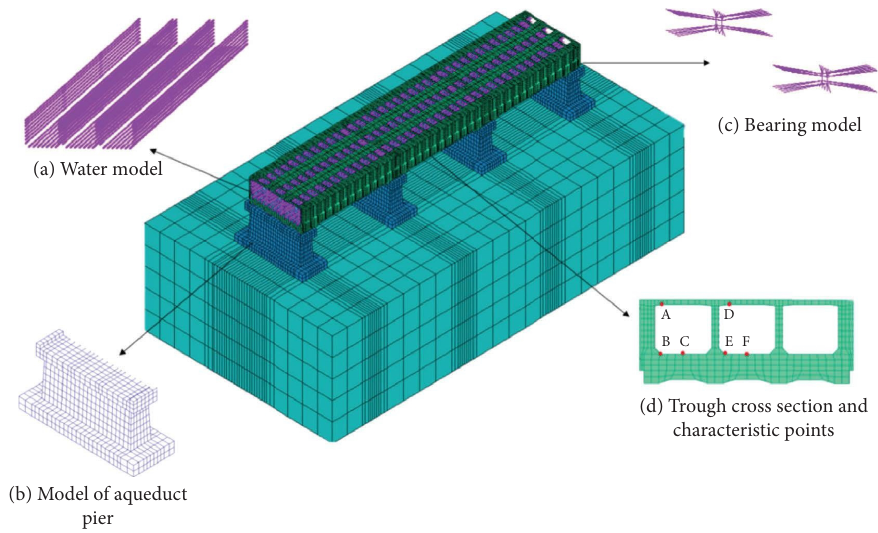
Figure 9: Tree-dimensional fnite element model. Table 3: Comparison table of natural frequencies of aqueduct structure with diferent supports under diferent water depth cases. Fundamental frequency (Hz) rubber bearing